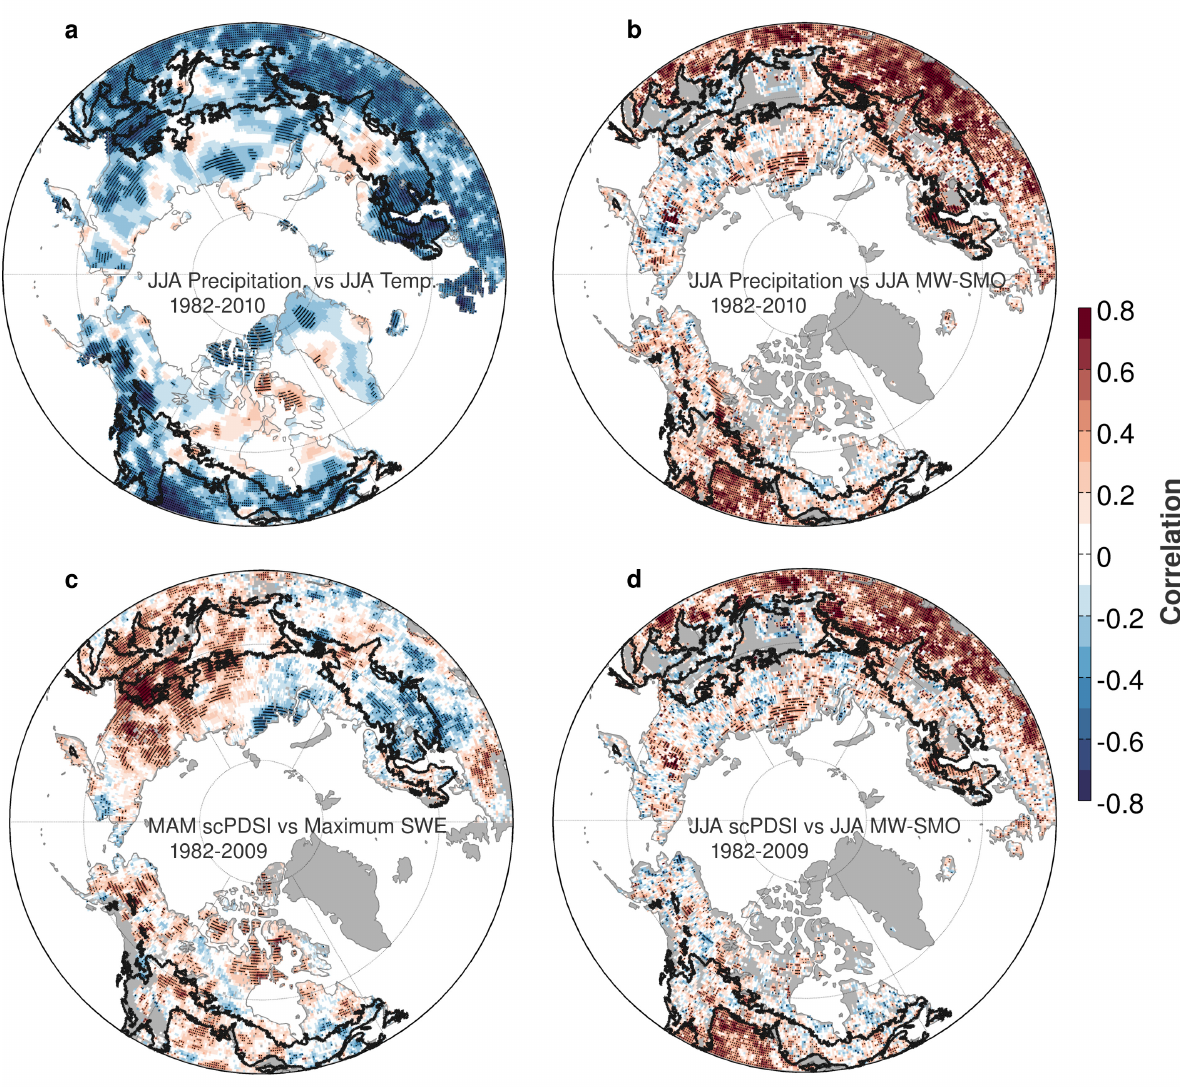
Figure A6. Correlation between linearly detrended climate fields. ( a ) Correlation of summer precipitation with summer temperature; ( b ) Correlation of summer precipitation with summer MW-SMO; ( c ) Correlation between spring scPDSI and maximum SWE; ( d ) Correlation between summer scPDSI and summer MW-SMO. The stippling indicates statistically significant ( p < 0.1)